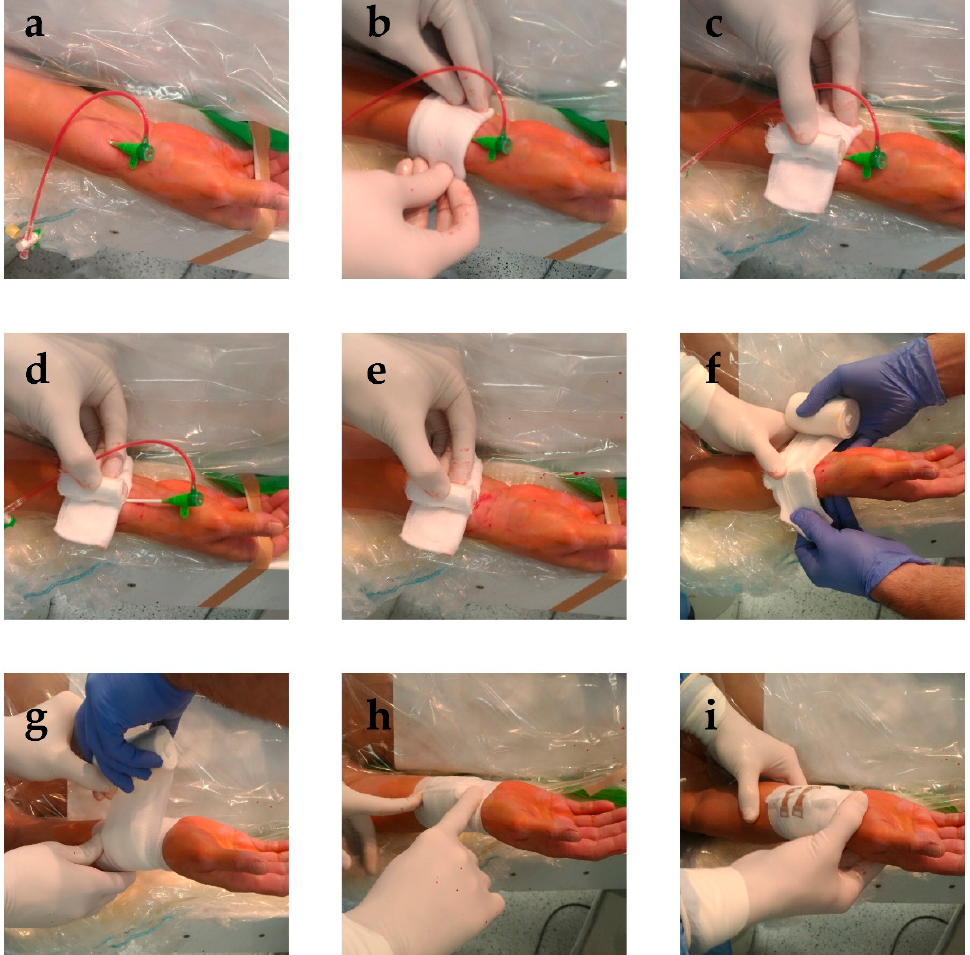
Figure 1. Placement of the vial compression. ( a ) After completion of the procedure, the surroundings of the access site are cleaned. ( b ) A sterile gauze is placed above the access site, with the sheath still in place. ( c ) The reused vial wrapped in sterile gauze is placed above the access site, with its longer axis parallel to the radial artery. ( d ) The sheath is then removed, ( e ) while applying sufficient pressure to prevent bleeding. ( f , g ) An elastic bandage is then wound six times around the vial, ( h ) after which it is cut above the access site. ( i ) After the loose end of the elastic bandage is secured, the compression is functional.